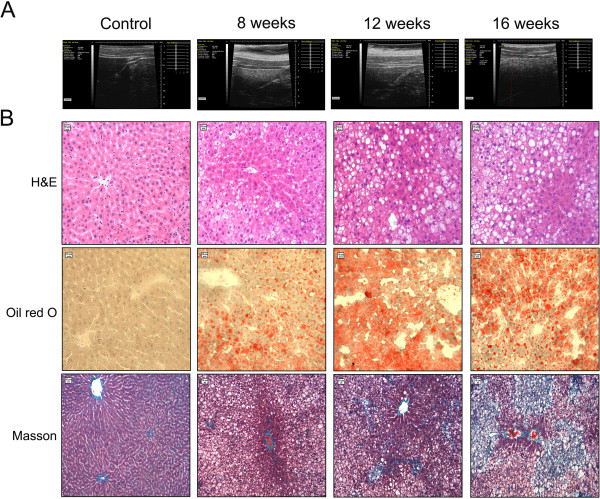
Ultrasound and histological findings of livers from NAFLD rats fed a high-fat diet for 8, 12 and 16 weeks, respectively. (A) Ultrasonographic representation (40 MHz) of the liver in transverse section. Transversal sonogram of Control group (normal liver) demonstrates homogeneous liver parenchyma, with medium level echogenicity and a regular hepatic surface (arrowheads). Transversal sonogram of liver in rats fed a high-fat diet for 8, 12 and 16 weeks, presents diffusely increased parenchymal echogenicity, the edge blunter, discrete coarse and heterogeneous parenchymal echogenicity and the liver surface as a dotted or slightly irregular line. (B) Histochemical analyses of liver specimens from rats stained with haematoxylin and eosin (H & E),oil red O and Masson’s. Rats fed a high-fat diet for 8 weeks show steatosis, predominantly as microvesicular fat in the acinar zones 1 and 2. Rats fed a high-fat diet for 12 and 16 weeks show pronounced hepatic steatosis, ballooning degeneration, infiltration of inflammatory cells (arrowhead), piecemeal necrosis (stars), fibrous tissue deposition and formation of fat granulomas (arrows). Objective lens, ×20.